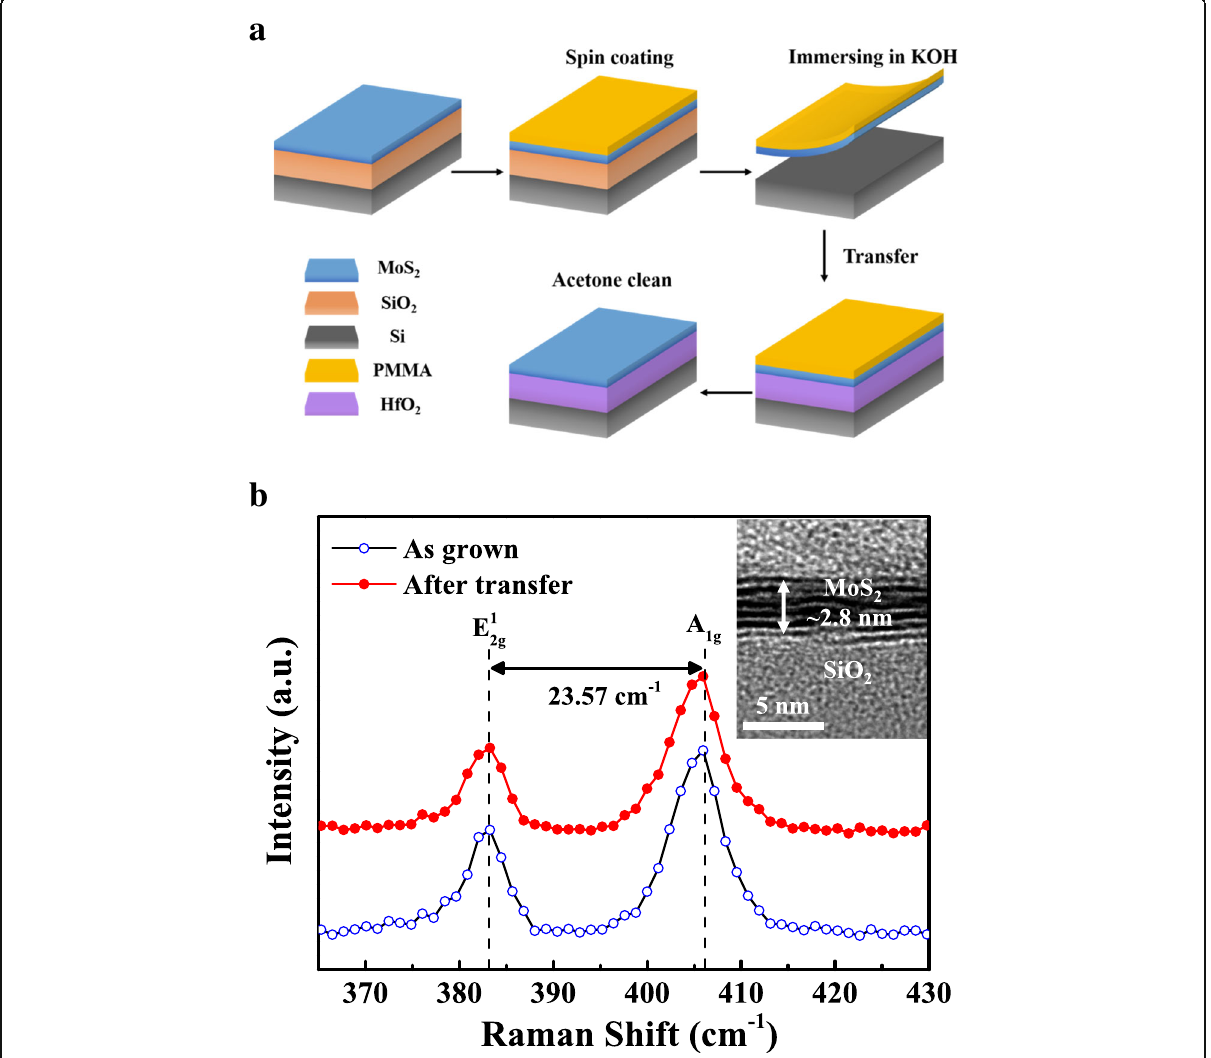
Fig. 1 a Process flow of PMMA-assisted wet transfer method for the MoS 2 /ALD-HfO 2 heterojunction formation. b Respective Raman spectra of as-grown and transferred MoS 2 film. The inset is the cross-section transmission electron microscopy images of as-grown MoS 2 on SiO 2 /Si